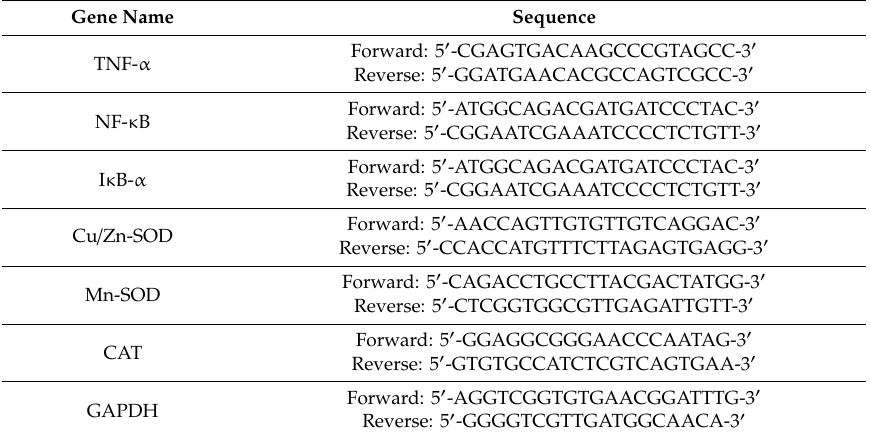
Table 1. Sequences of primers used in this study.